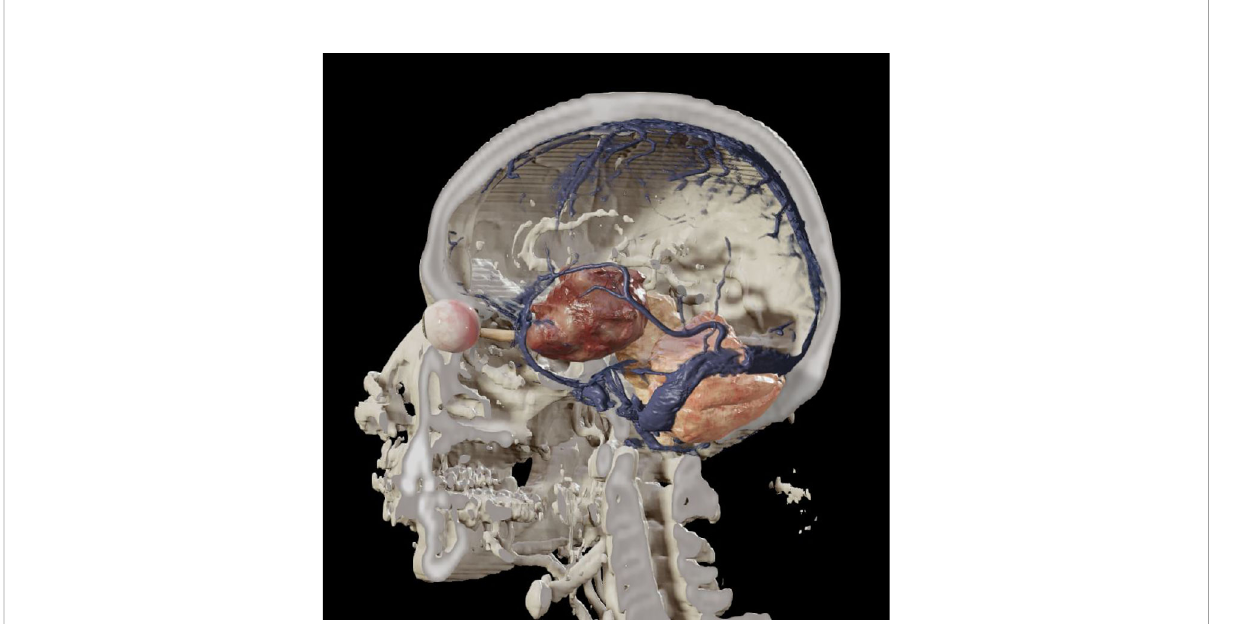
FIGURE 1 Coronal 3-D image depicting a tumor involving the left cavernous sinus that may be amenable to resection through a lateral transorbital endoscopic